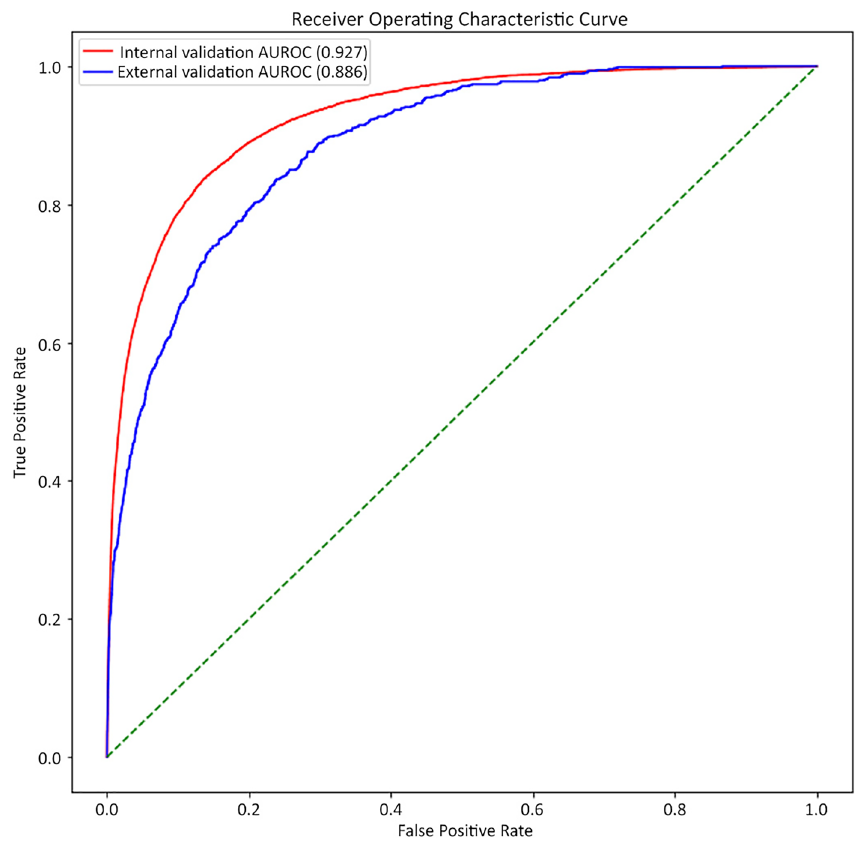
Figure 1. Receiver operating characteristics (ROC) curve for internal validation outcome on the time- validation